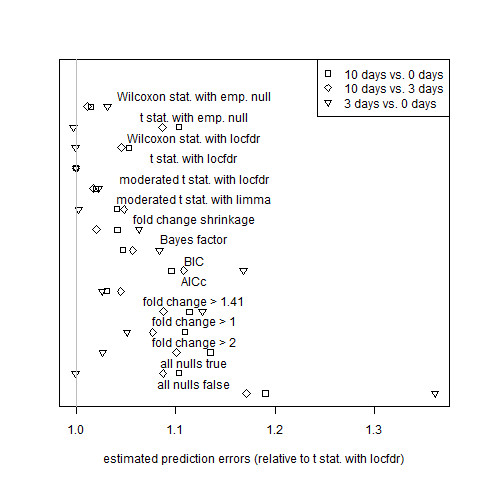
Assessment of estimator performance by cross validation for the non-paired tomato data sets. Average estimated prediction error for the comparing expression at 10 days to 0 days, 10 days to 3 days, and 3 days to 0 days after the breaker stage of ripening. Error and algorithm definitions are the same as those of Figure 1.